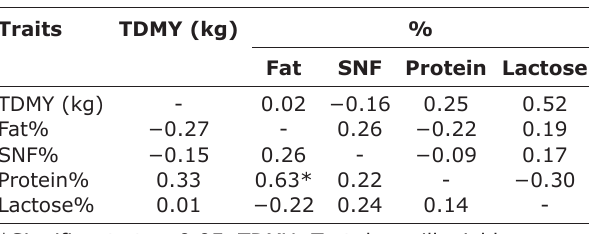
Table-2: Correlation coefficients between milk yield and composition traits at day 15 (above diagonal) and day 60 postpartum (below diagonal) in Surti buffaloes.